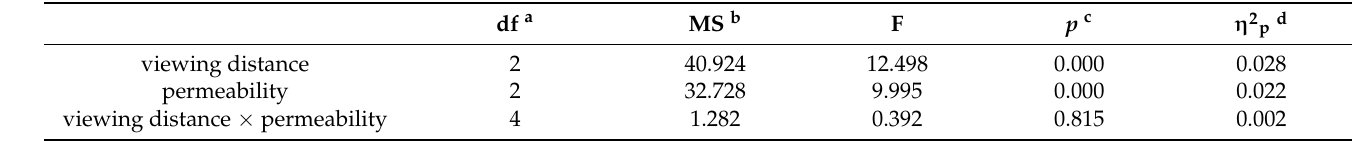
Table 17. Impacts of different viewing distances and edge permeability levels on perceived depression.